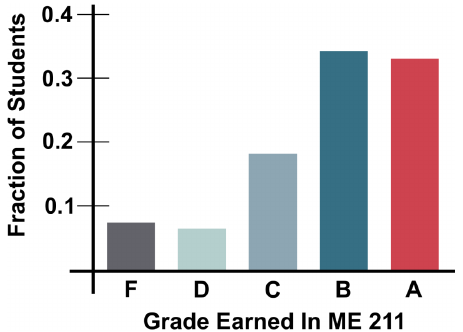
FIG. 4. The aggregated grade distribution for ME 211 between the fall semester of 2015 through the spring semester of